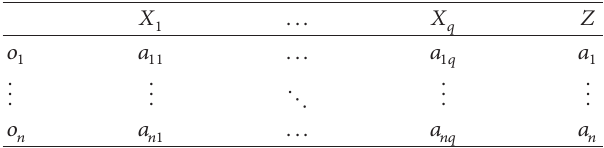
Table 2: Standard GUHA table.